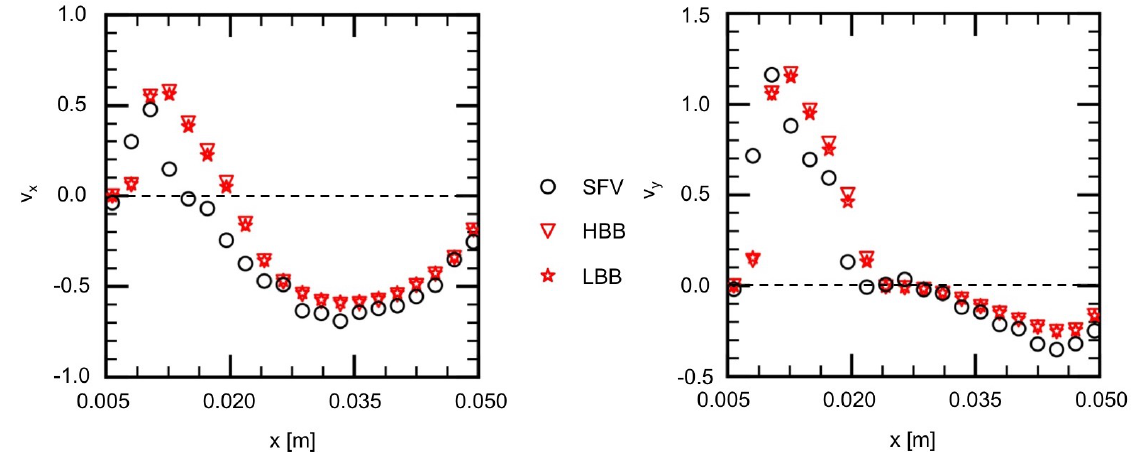
Figure 9. Comparison of velocity components between measured (SFV), HBB and LBB (line H1).